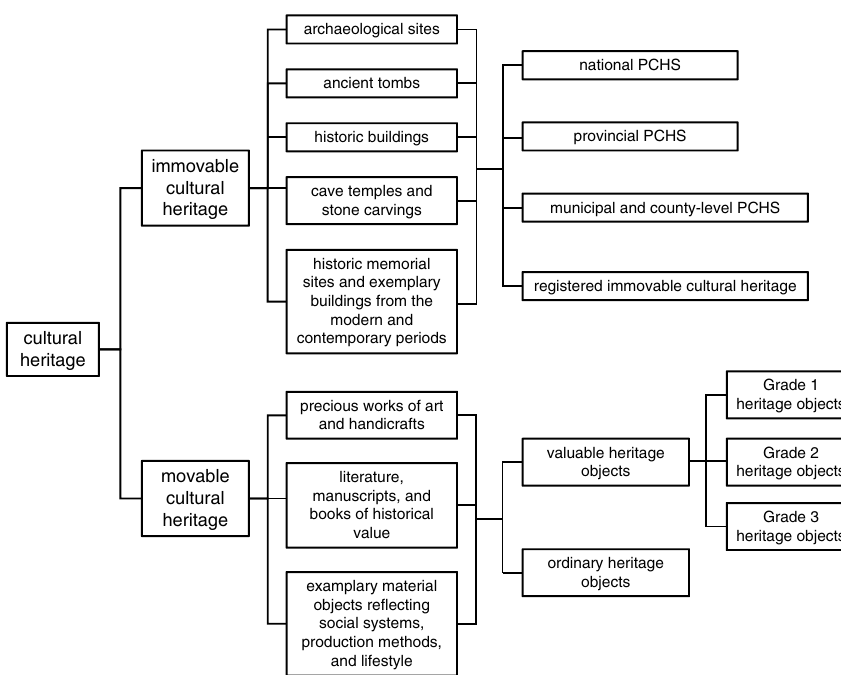
Fig. 1 Categories of cultural heritage under the CHPL (Source: the